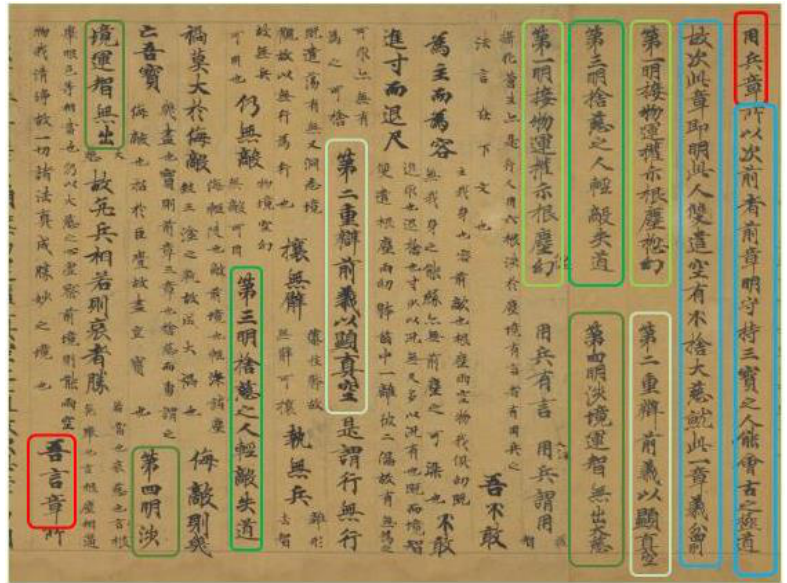
Figure 1. Excerpt of Dunhuang Manuscript P 2517, Gallica, Bibliotheque Nationale de France, Pelliot ms 2517. Daode jing yishu , chapter 69: chapter title (red), structuring commentary (blue), synopses of subdivisions (different shades of green) marked by author.